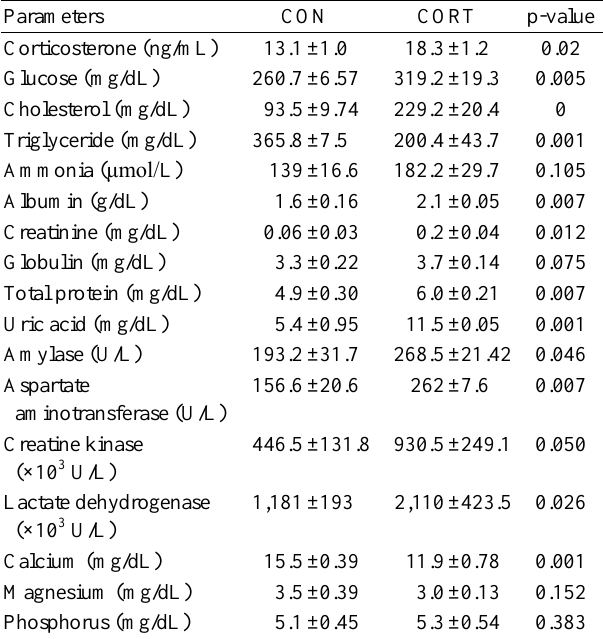
Table 1. Effects of dietary corticosterone on plasma concentrations of corticosterone,